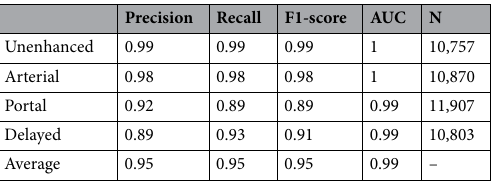
Table 3. Performance metrics in the testing set for the slices evaluation using the best model found by the Hyperparameter tuning.